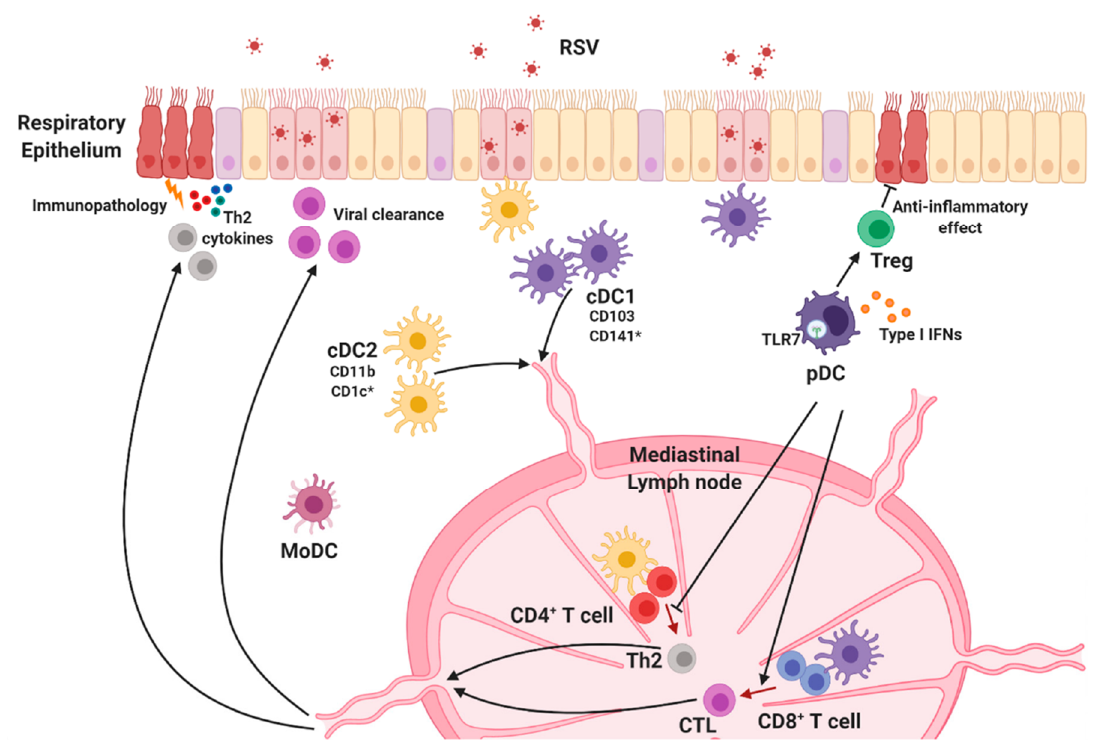
Figure 3. Lung dendritic cell subsets. Lung DCs are classified into conventional DC1s (cDC1s), cDC2s, and plasmacytoid DCs (pDCs). Each DC subset is widely distributed throughout the lungs and migrates to the lung-draining lymph node when they recognize RSV to initiate protective immune responses. cDC1s preferentially activate CD8 + T cells that mediate viral clearance, and cDC2s are responsible for Th2-mediated immune responses and RSV-mediated pulmonary diseases. pDCs are the main source of type I interferons (IFNs) and play an essential role in RSV-specific cytotoxic T lymphocyte (CTL) priming and regulation of disease severity. * Human-specific